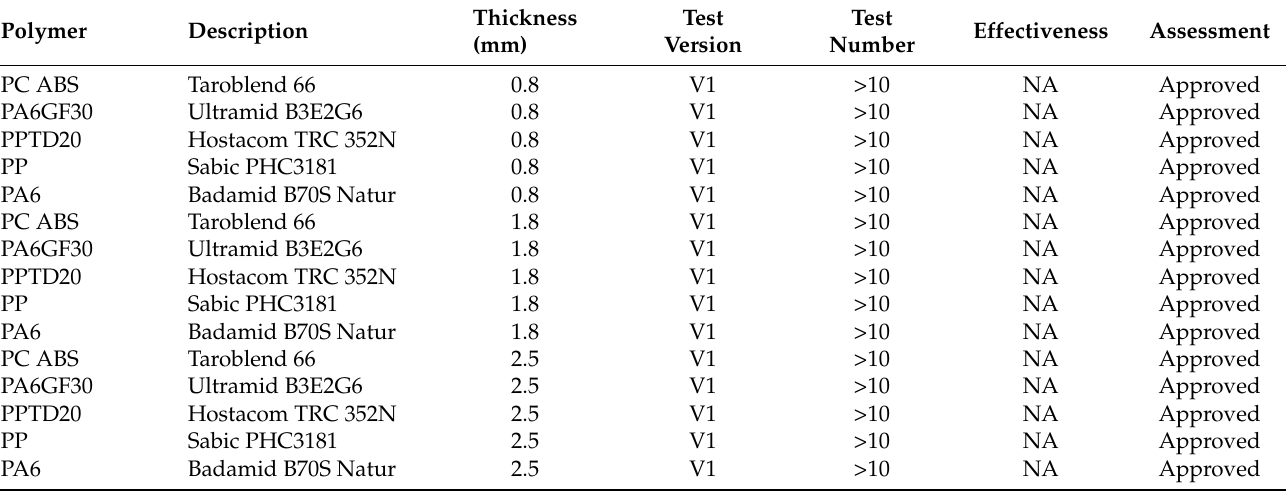
Table 2. Preliminary tests to test the permissible plastic thickness (for sensor